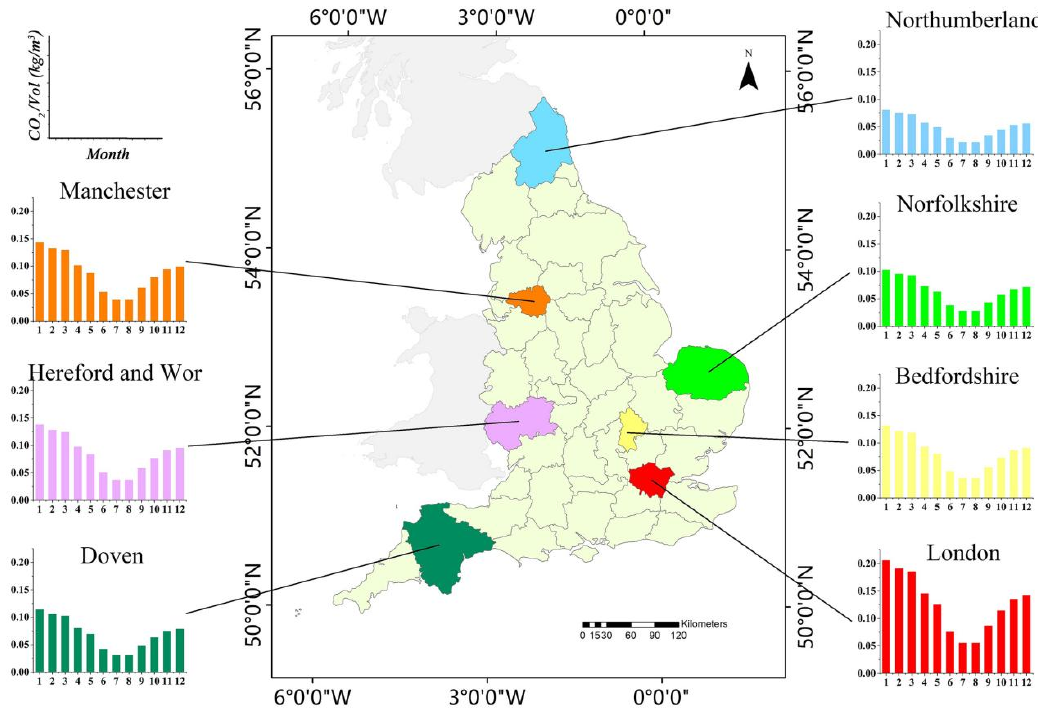
Figure 9. Ratio of CO 2 emissions per volume of seven counties.